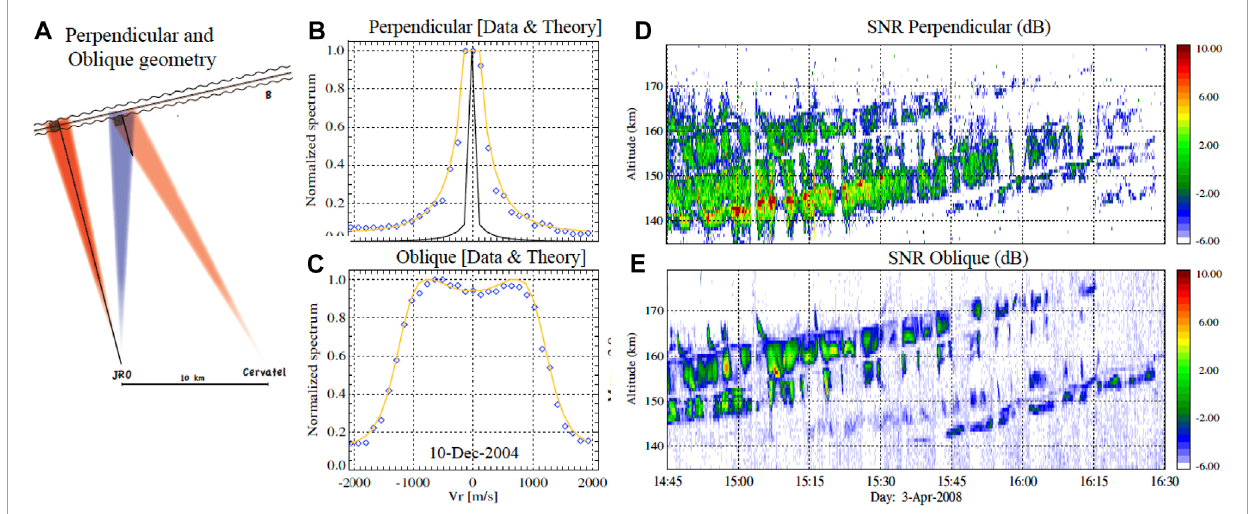
FIGURE 6 Simultaneous perpendicular and oblique observations of 150-km echoes over Jicamarca between 2004 and 2008: (A) Monostatic and bistatic geometries for perpendicular (red) and oblique (blue) beam; 3-min measured normalized-to-the-peak spectrum (blue circles) at 160 km for (B) perpendicular and (C) oblique on 10-December-2004; altitude-time SNR for (D) perpendicular and (E) oblique beams on 03-April-2008. Note that in (B,C) fitted incoherent scatter spectra are indicated in solid orange lines. In (B) , the normalized spectra is shown with (black) and without (blue) low frequency components (adapted from Chau et al., 2009, Figures 1, 5,